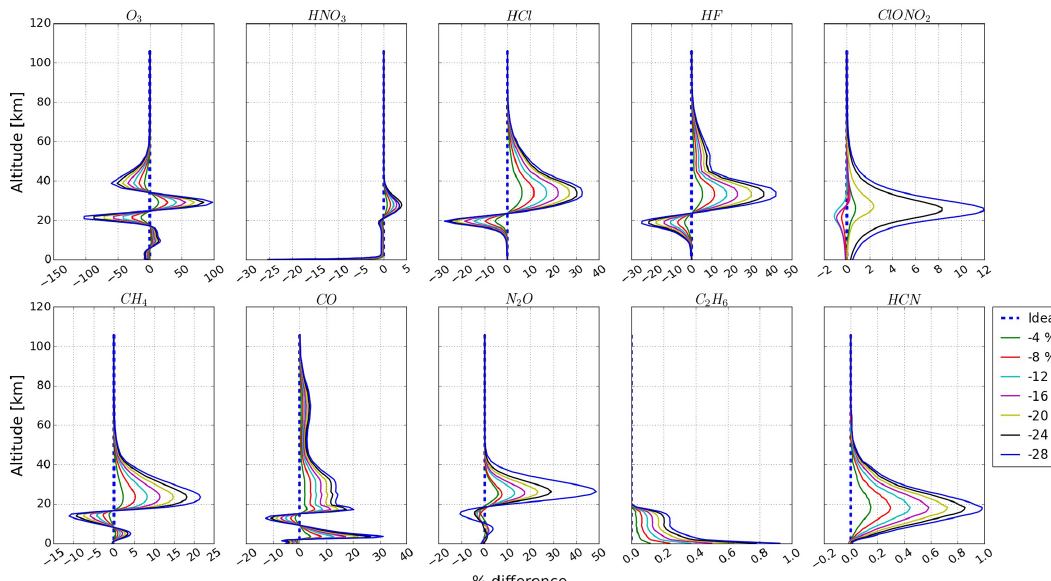
Figure 18. The same as Fig. 17 but for negative ME deviation.